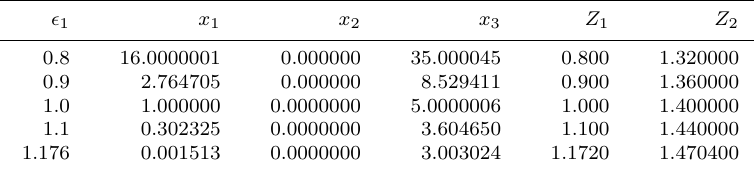
Table 4. Solution of Z 1 and Z 2 for different values of (cid:15) 1